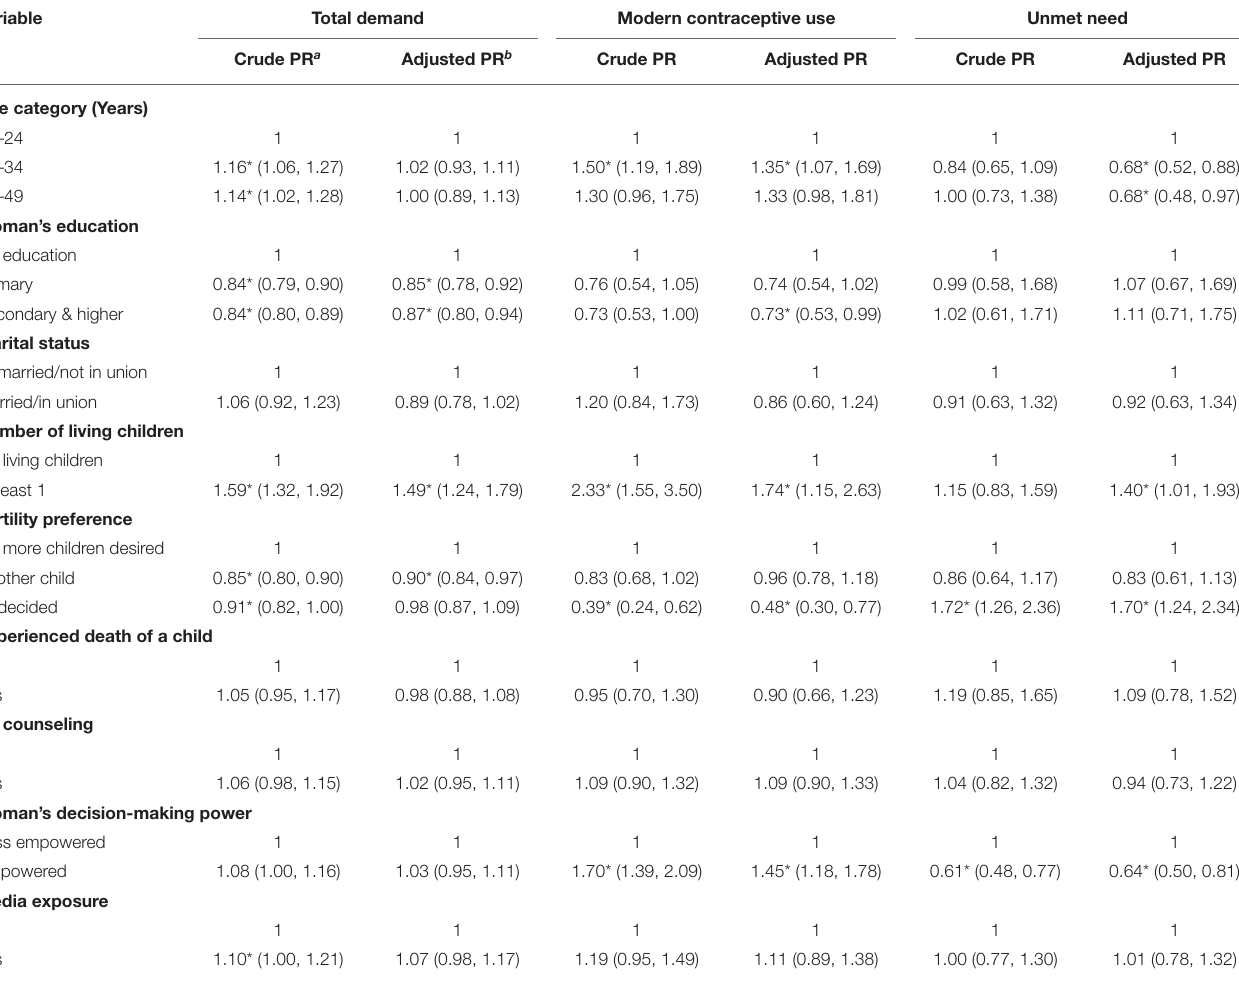
TABLE 3 | Factors associated with total demand, modern contraceptive use and unmet need for modern contraceptives among women of reproductive age in Kira Municipality, Uganda.